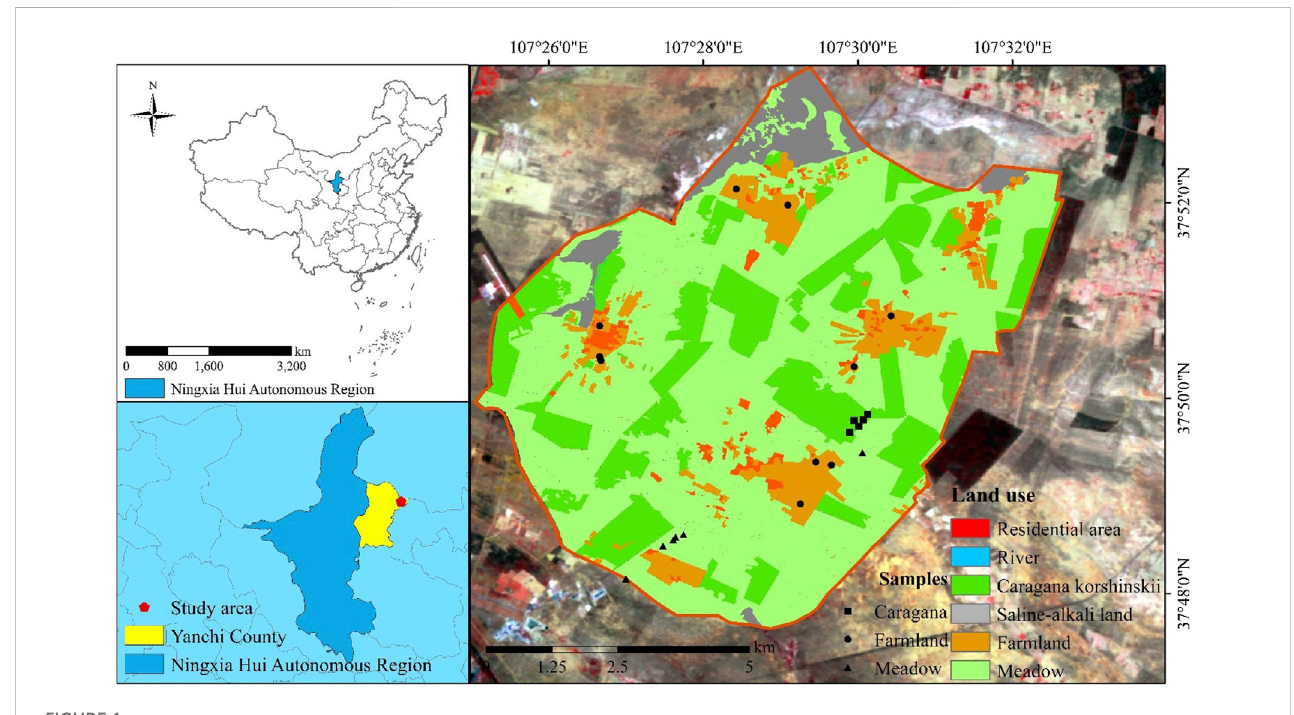
FIGURE 1 Schematic diagram of the study area and sample point distribution.